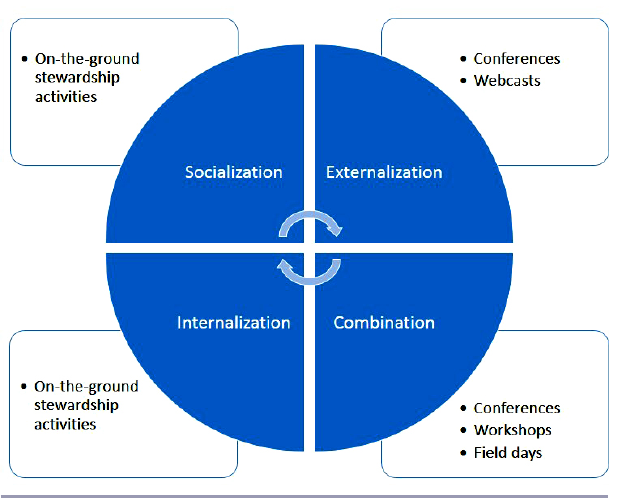
Fig. 3. The Stewardship Network’s stewardship learning model based on Nonaka